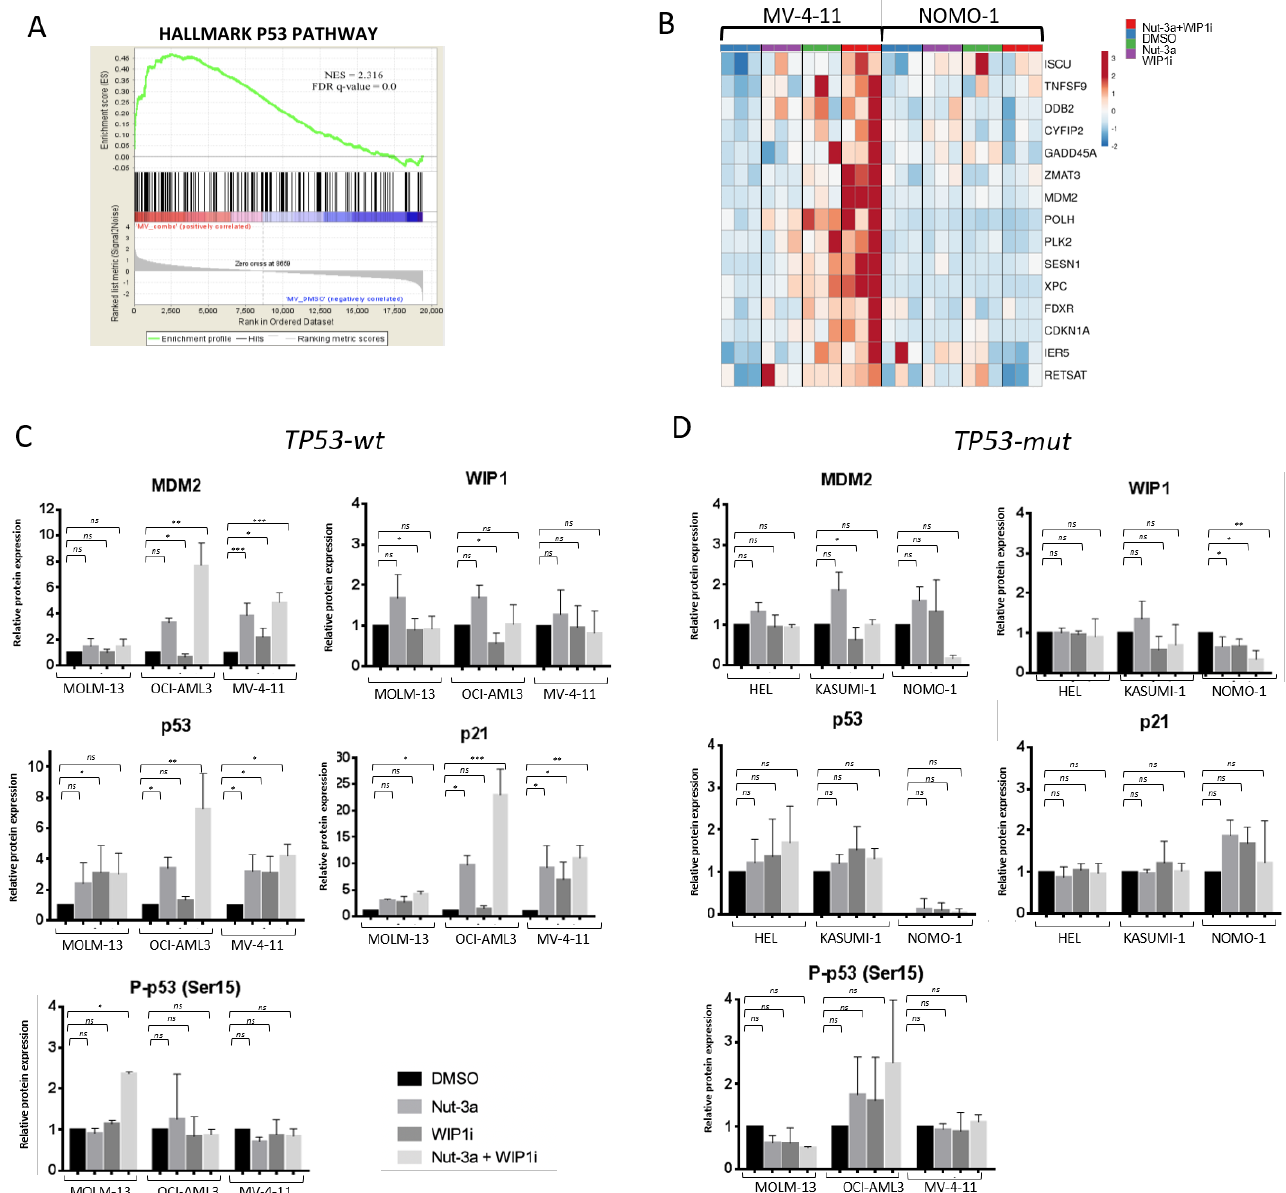
Figure 4. Changes in the expression of p53-related genes induced by the treatment in TP53 -wt and TP53 -mut cells. Cells were harvested after 16 h of treatment (Nut-3a 0.5 and 5 µ M; WIP1i 5 and 20 µ M, for TP53 -wt and TP53 -mut cells, respectively) both for gene expression microarray and protein analyses. ( A ) Enrichment of p53 signature in MV-4-11 cells treated with the drug combination vs. vehicle (gene expression microarray). ( B ) Heatmap of MV-4-11 and NOMO-1 cells showing the significantly deregulated genes (differential expression analysis between Nut-3a+WIP1i-treated and vehicle-treated MV-4-11 cells, fold change ≥ 2, p < 0.05) belonging to the p53 signature in the analyzed models. ( C ) Protein quantification of p53-related genes in treated TP53 -wt and ( D ) TP53 -mut cells. Histograms show the average value of 3 independent experiments ± SD (* p < 0.05, ** p < 0.01, *** p < 0.001, ns: not significant).